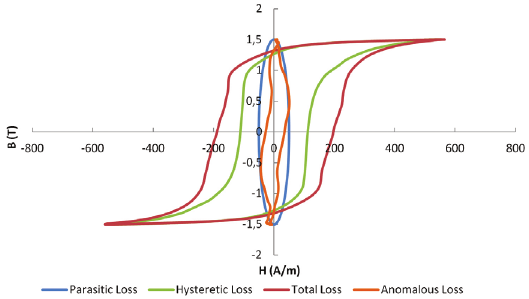
Figure 5. Loss separation for GO samples using peak induction 1.5 T and frequency 60 Hz.